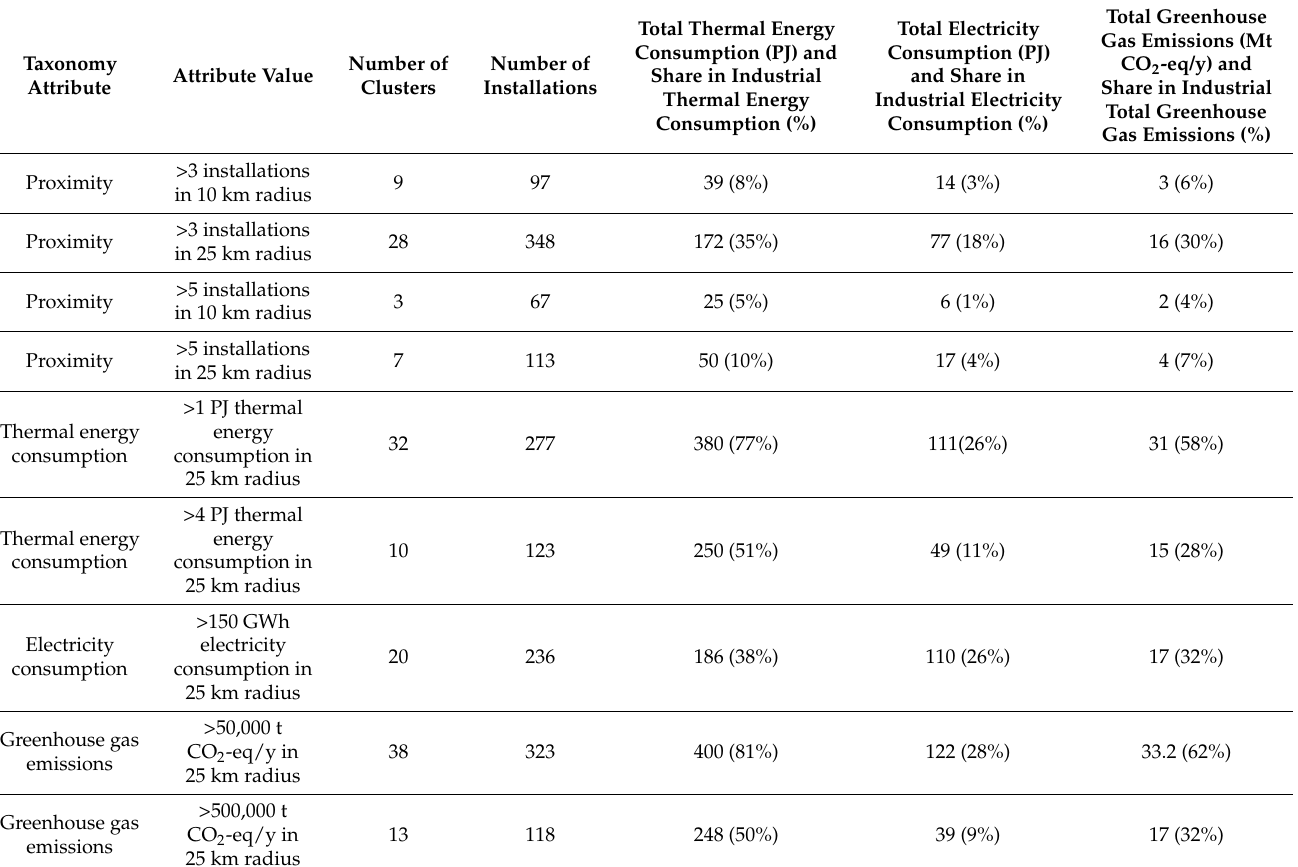
Table 10. Relevance of industrial clustering for energy consumption and emissions in